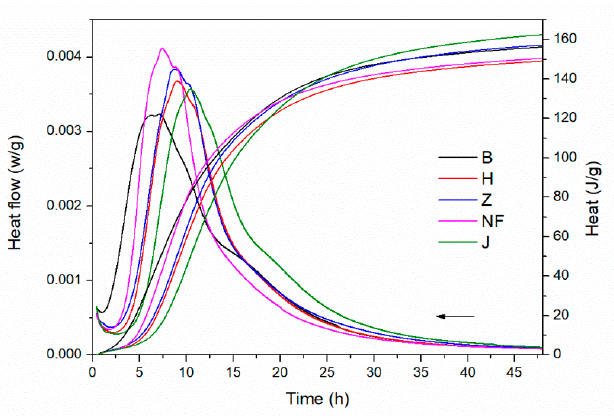
Figure 4. Effects of different superplasticizers on the heat of cement hydration.